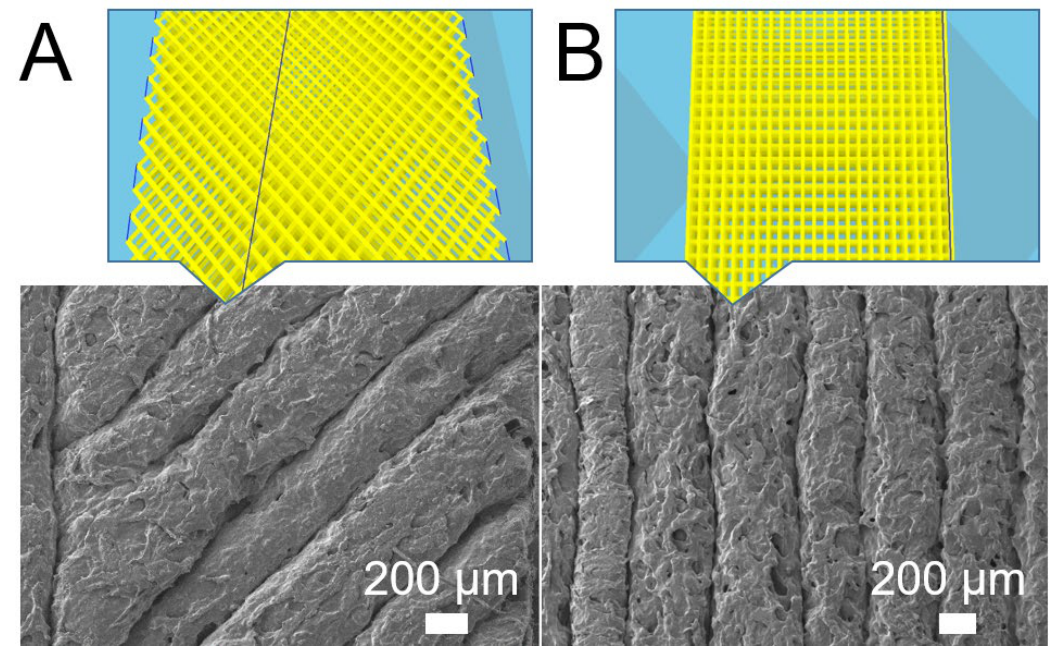
Figure 10. Print orientation and the SEM image of the printed composite parts (( A ): 45°, ( B ): 90°).